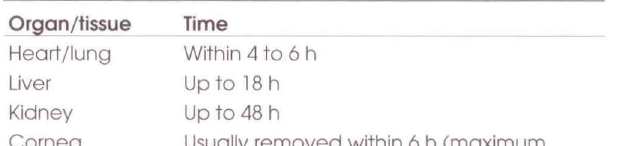
Time interval adopted in practice between removal of organ or tissue from donor and transplantation into